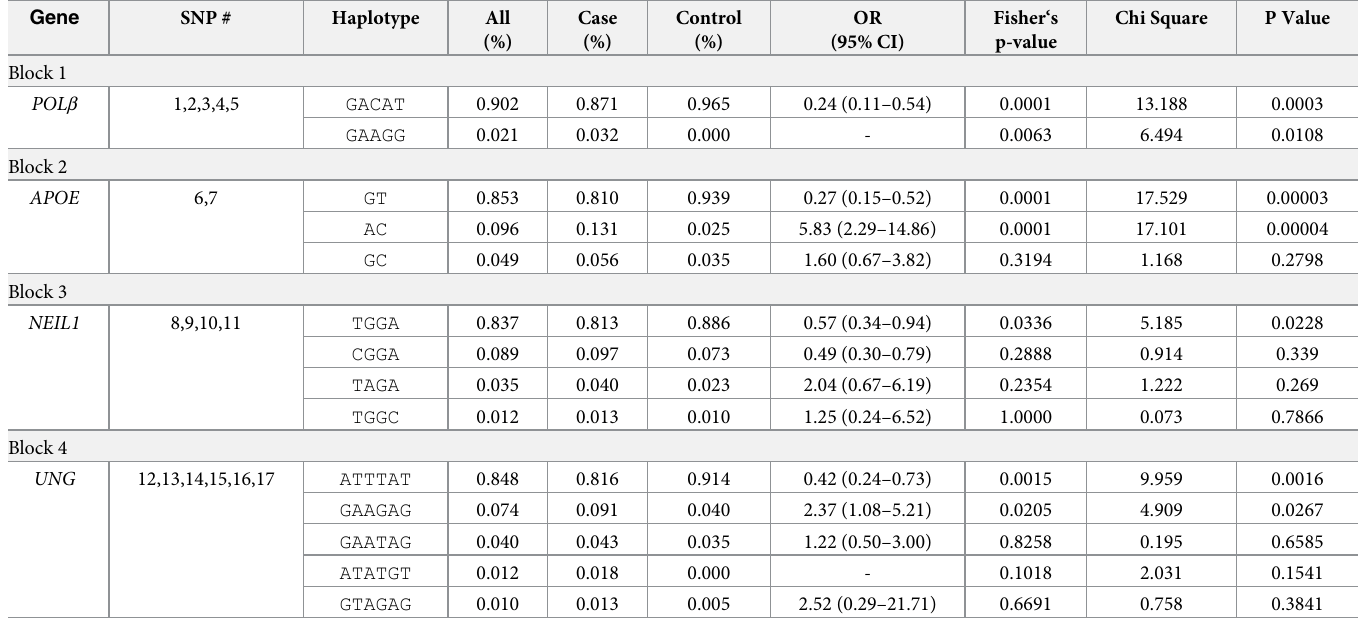
Table 6. Haplotype analysis of all studied LOAD blood gene